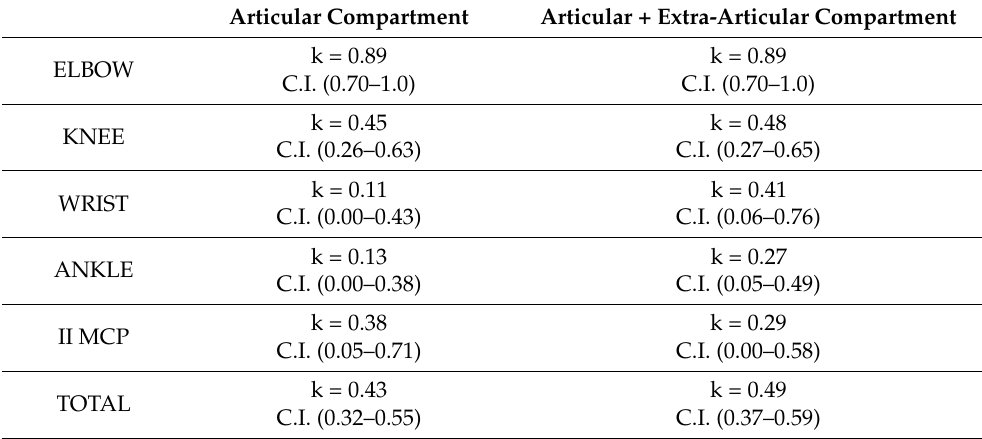
Table 3. Concordance between physical examinations and MSUS, considering the articular com- partment alone and the articular + extra-articular compartment. Concordance was evaluated using